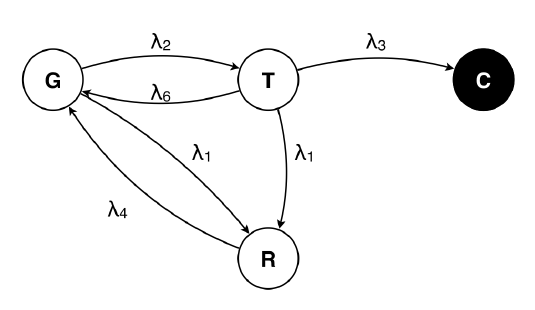
Figure 3. CTMC model with an absorbing